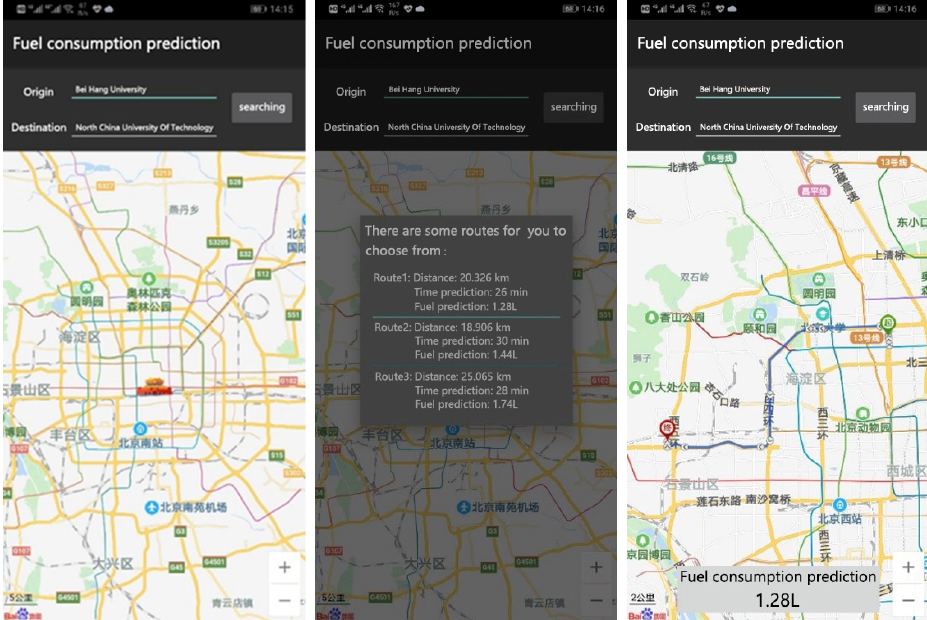
Figure 7. The specific flow chart of the fuel consumption predictions.